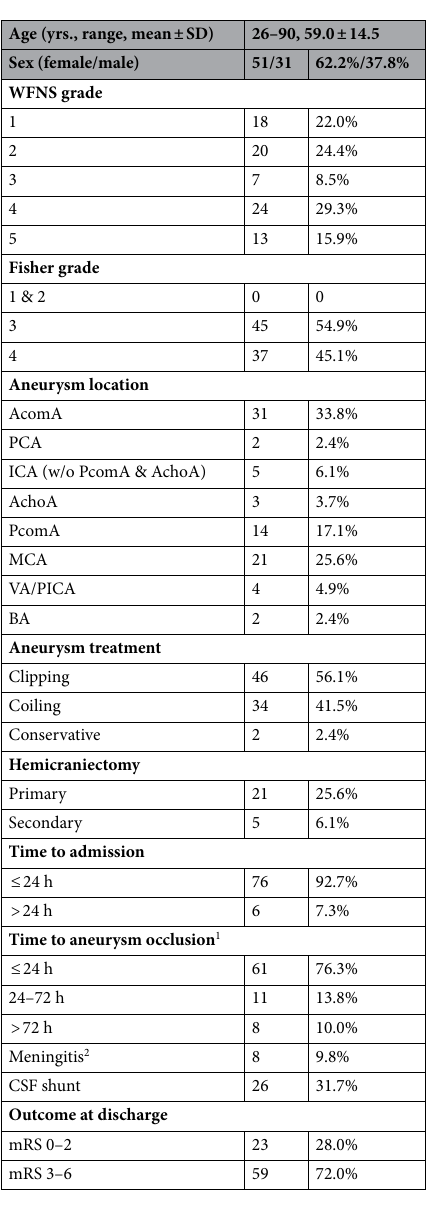
Table 1. Patient demographics, treatment and outcome data. 1 Excluding 2 cases managed conservatively. 2 Culture-positive meningitis. AchoA anterior choroidal artery, AcomA anterior communicating artery, BA basilar artery, CSF cerebrospinal fluid, h . hours, ICA internal carotid artery, MCA middle cerebral artery, mRS modified Rankin scale, PCA posterior cerebral artery, PcomA posterior communicating artery, PICA posterior inferior cerebellar artery, SD standard deviation, VA vertebral artery, WFNS World Federation of Neurosurgical Societies, yrs .